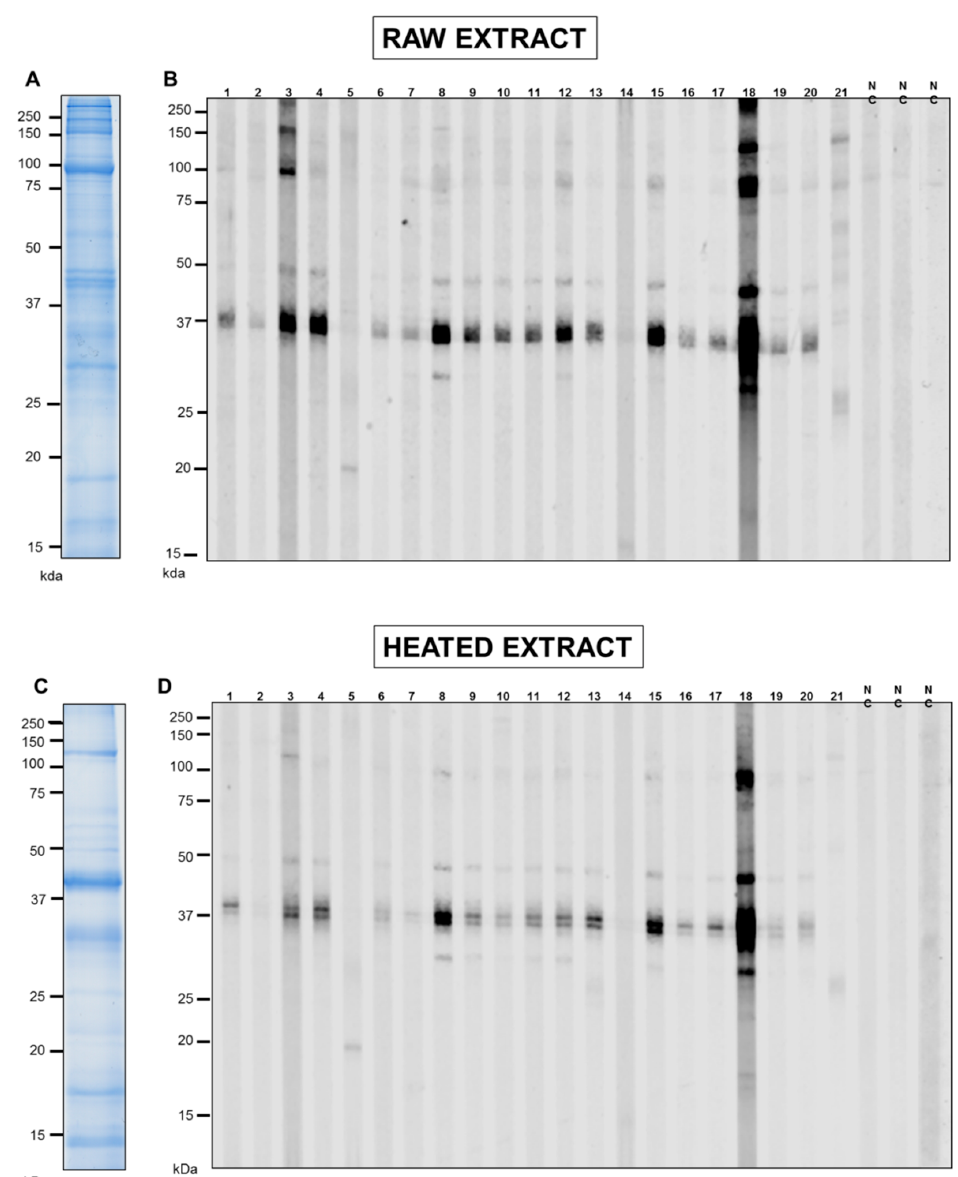
Figure 1. IgE reactivity of oyster-sensitised patients to raw and heated oyster extract ( top and bottom ). The extracts were separated by SDS-PAGE and stained with Coomassie Brilliant Blue ( A , C ). Immunoblots were performed with sera from 21 oyster-sensitised patients (1–21, B , D ) as well as from 3 individuals non-allergic to oyster (NC).